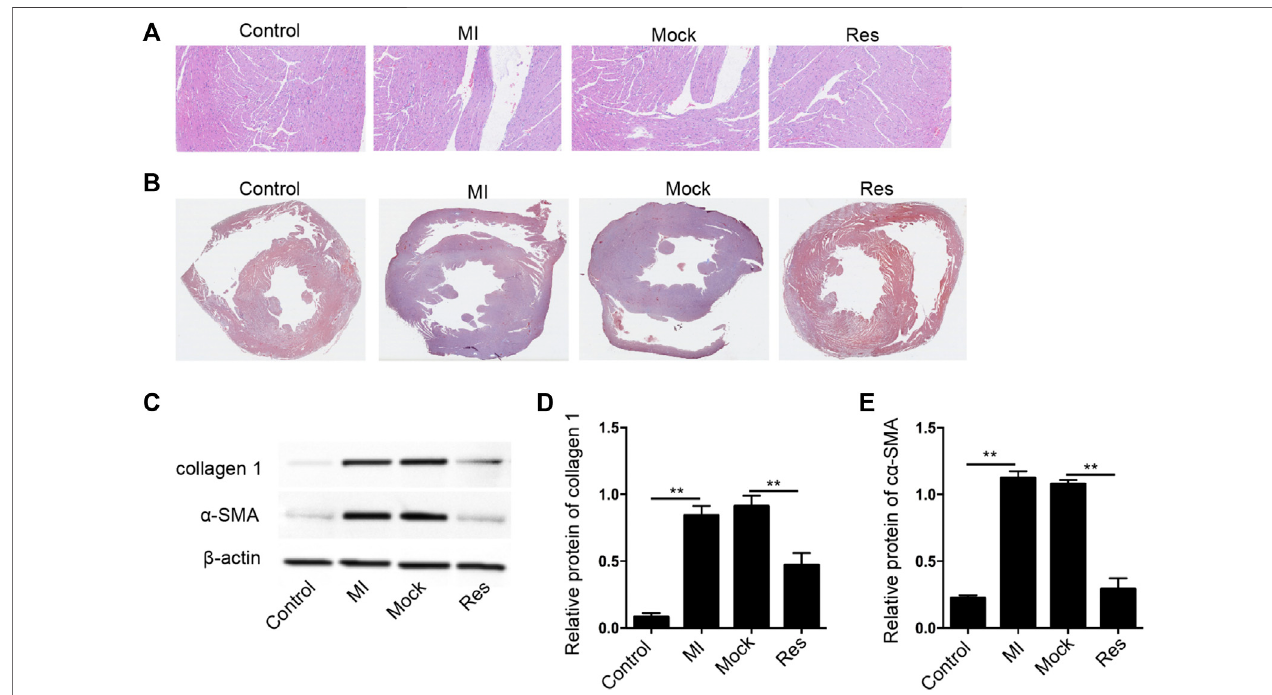
FIGURE1| Resattenuates myocardialinjury inMIrats (A – E) The MIratswere injected withRes( n =5for each group). (A) The myocardium injury wasanalyzed by Hematoxylin & Eosin (H&E) staining (B) The myocardial fi brosis was measured by Masson ’ s staining. (C – E) The expression of collagen 1 and α -SMA was detected by Western blot analysis and was normalized on the expression of β -actin. Data are presented as mean ± SD. Statistic signi fi cant differences were indicated: ** p < 0.01.